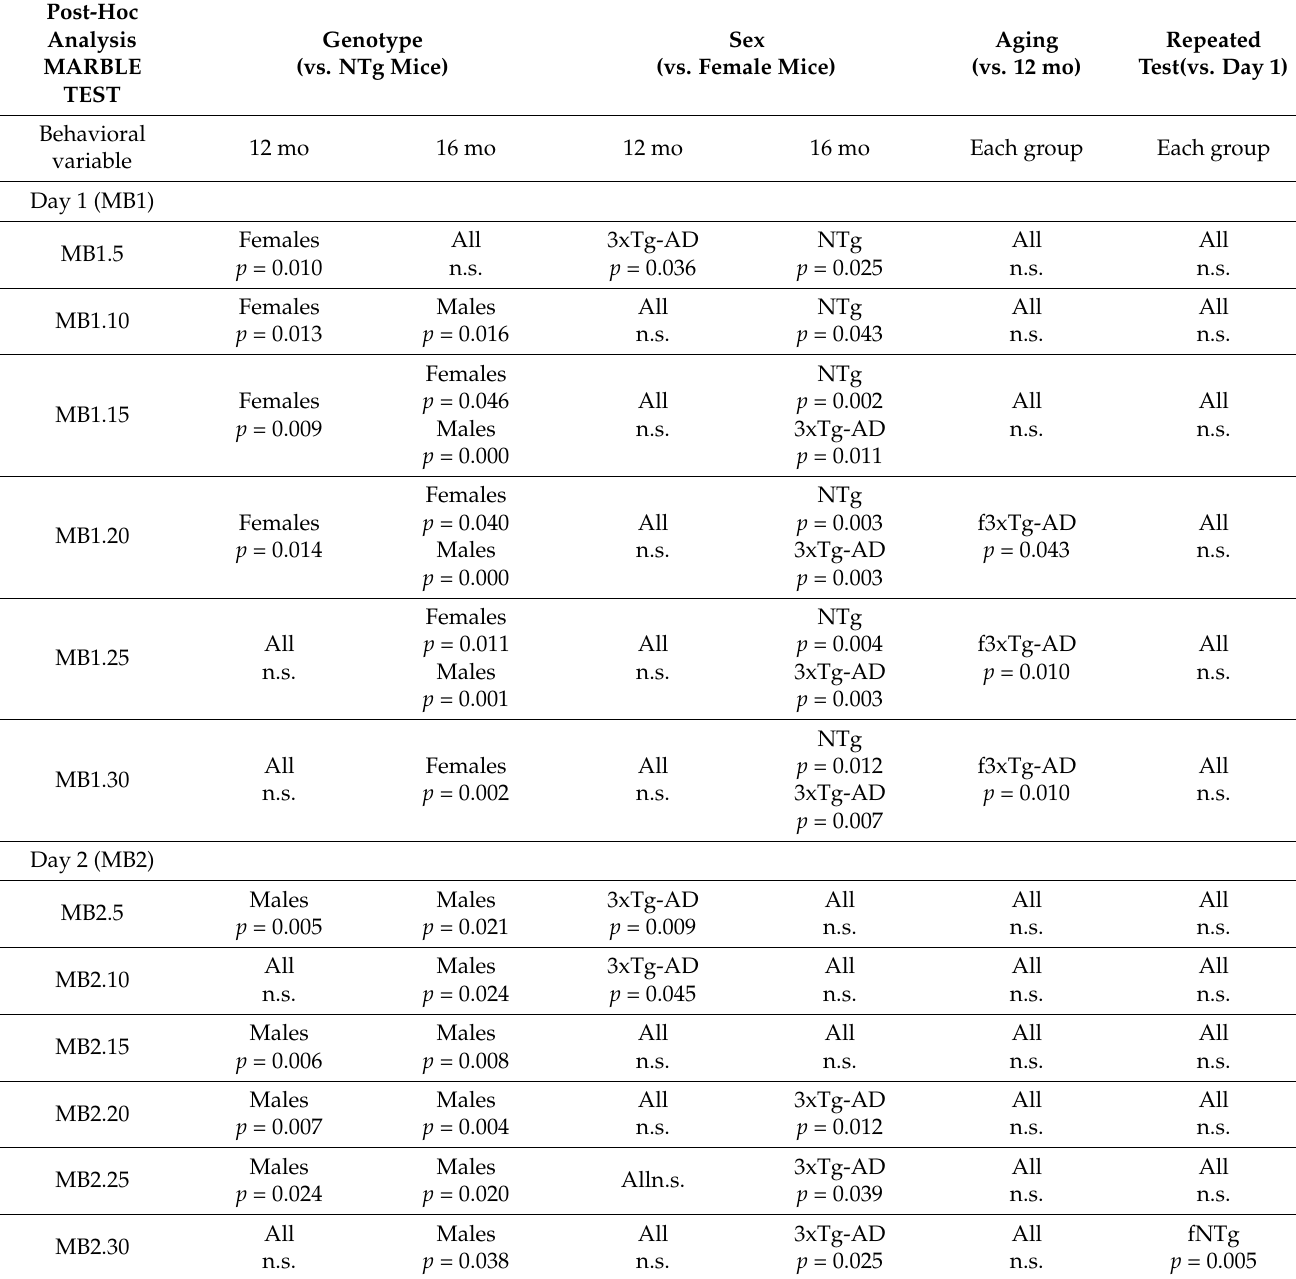
Table 2. Post-hoc analysis of genotype, sex, and aging differences in the marble